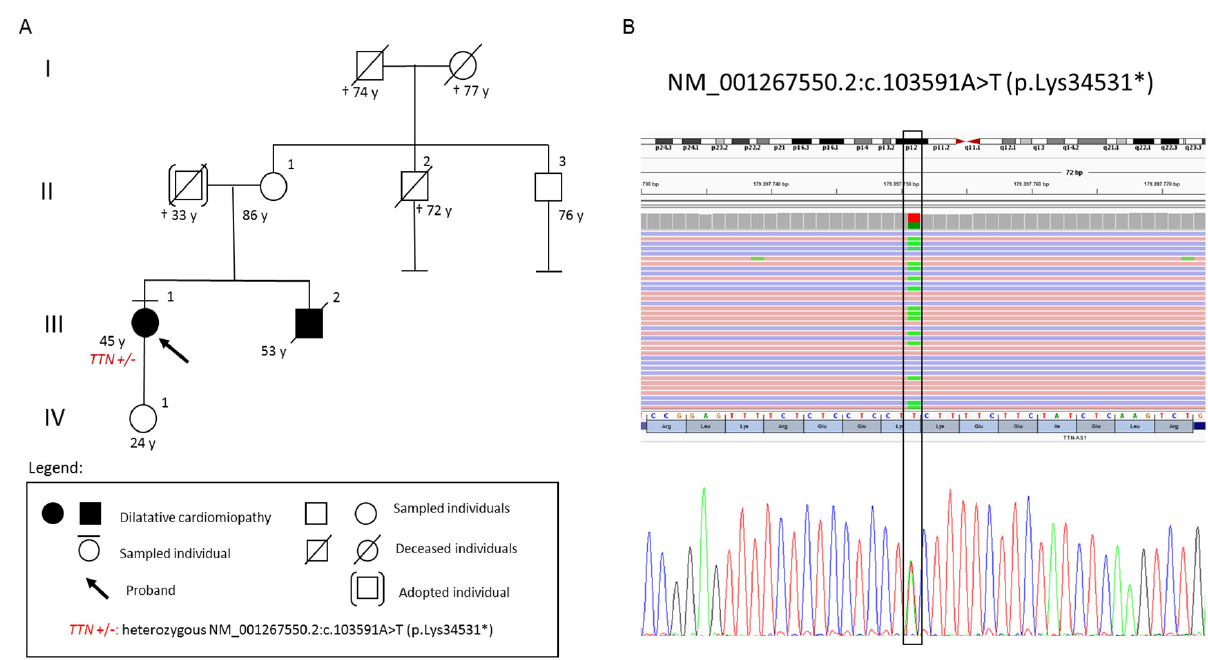
Figure 1. ( A ) Pedigree of the family showing the phenotypes of the affected relatives and the genotype of the proband. Male is represented by a square; female is represented by a circle. ( B ) Multi-gene panel analysis. NGS and Sanger sequencing of the proband showing the c.103591A > T (p.Lys34531*) in TTN on genomic DNA. The identified pathogenic variant in TTN is visualized by Integrative Genome Viewer (IGV) software. Ref Seq (Reference sequencing) used for variant annotation: NM_001267550.2. In November 2022, due to the sudden onset of shortness of breath, heartburn, and desaturation (SpO2 75%), she was escorted to the emergency room of our hospital.